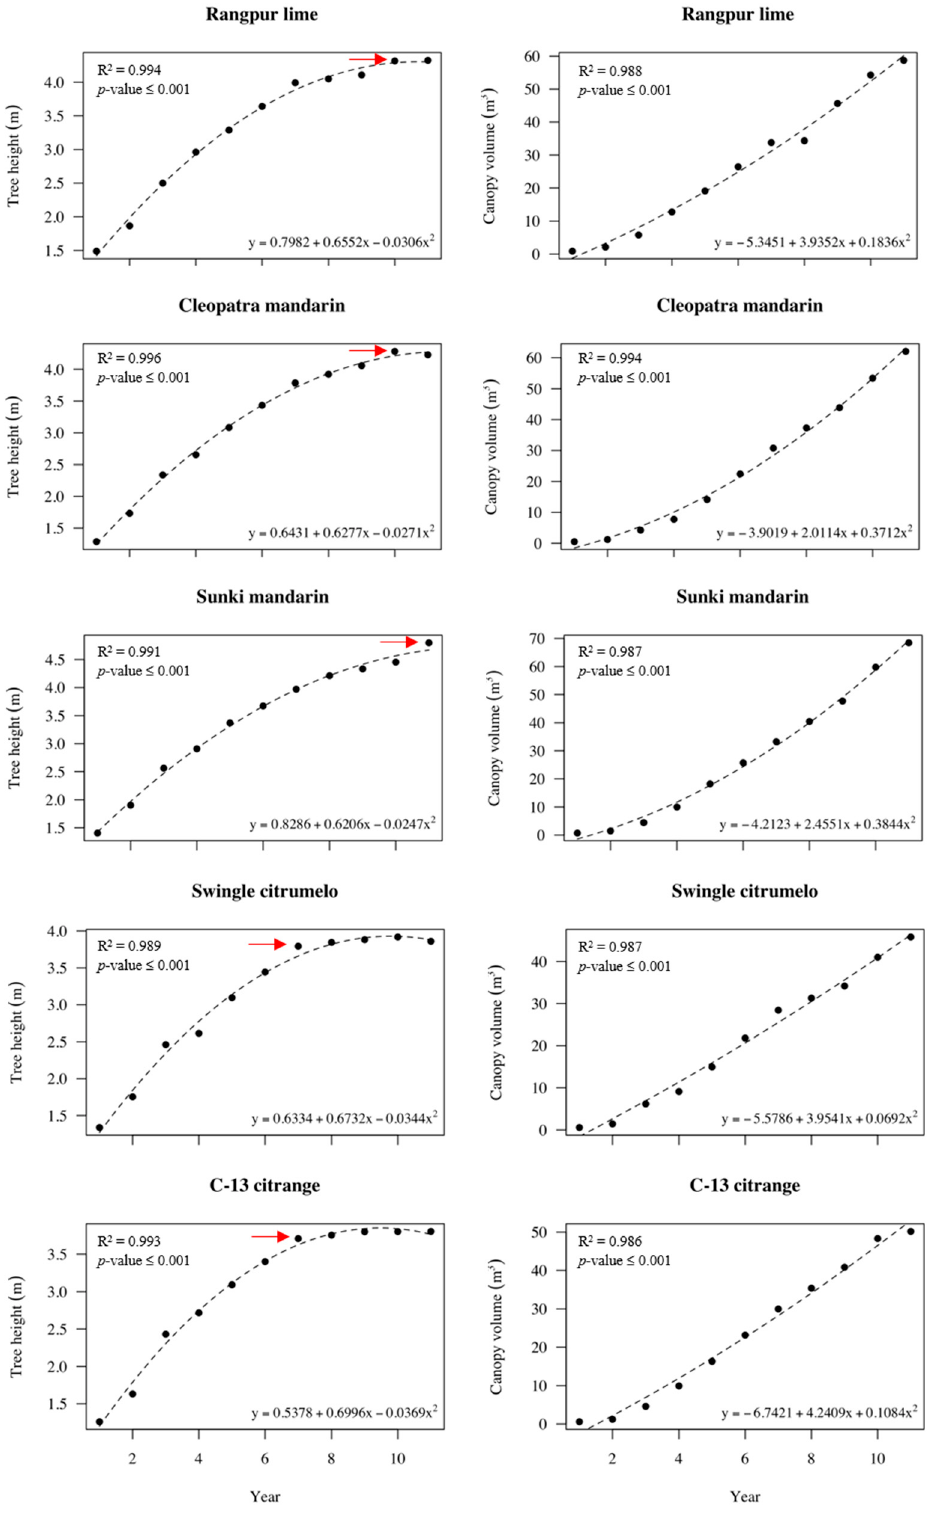
Figure 2. Tree height and canopy volume of ‘Shamouti’ sweet orange trees grafted on different rootstocks under the humid subtropical climate, from the period of two (2007) up to twelve (2017) years of age. Red arrows indicate the time when trees ceased growth in height.